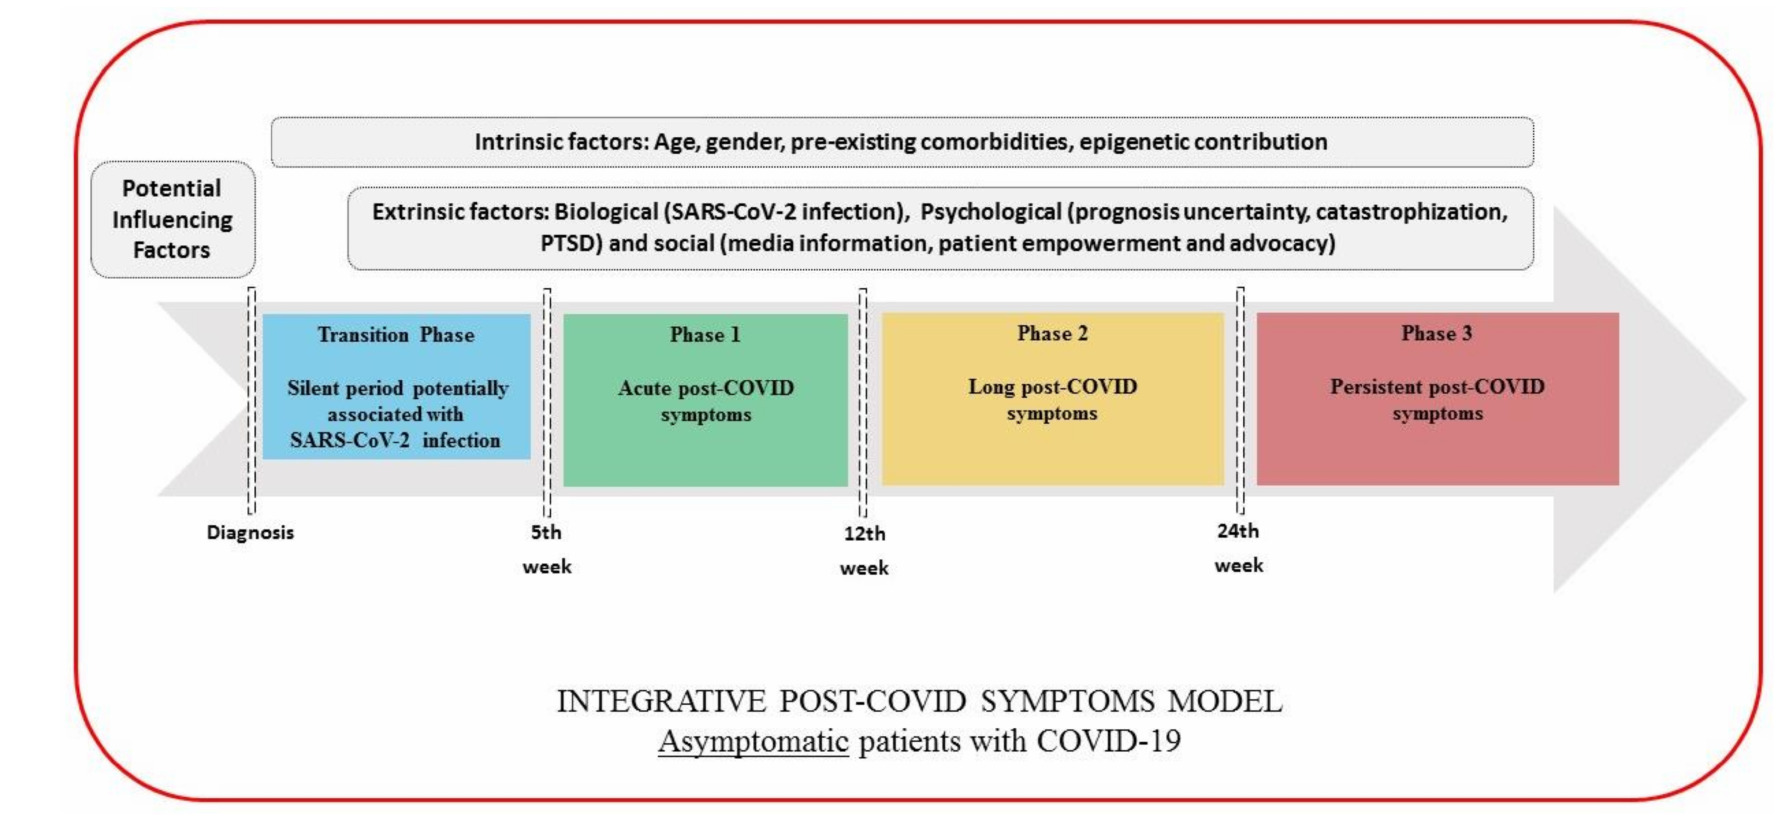
Figure 3. Integrative post-COVID symptoms model in asymptomatic individuals showing transition phase (blue), and phases 1 (green), 2 (yellow), and 3 (red) of post-COVID symptoms. PTSD: post-traumatic stress